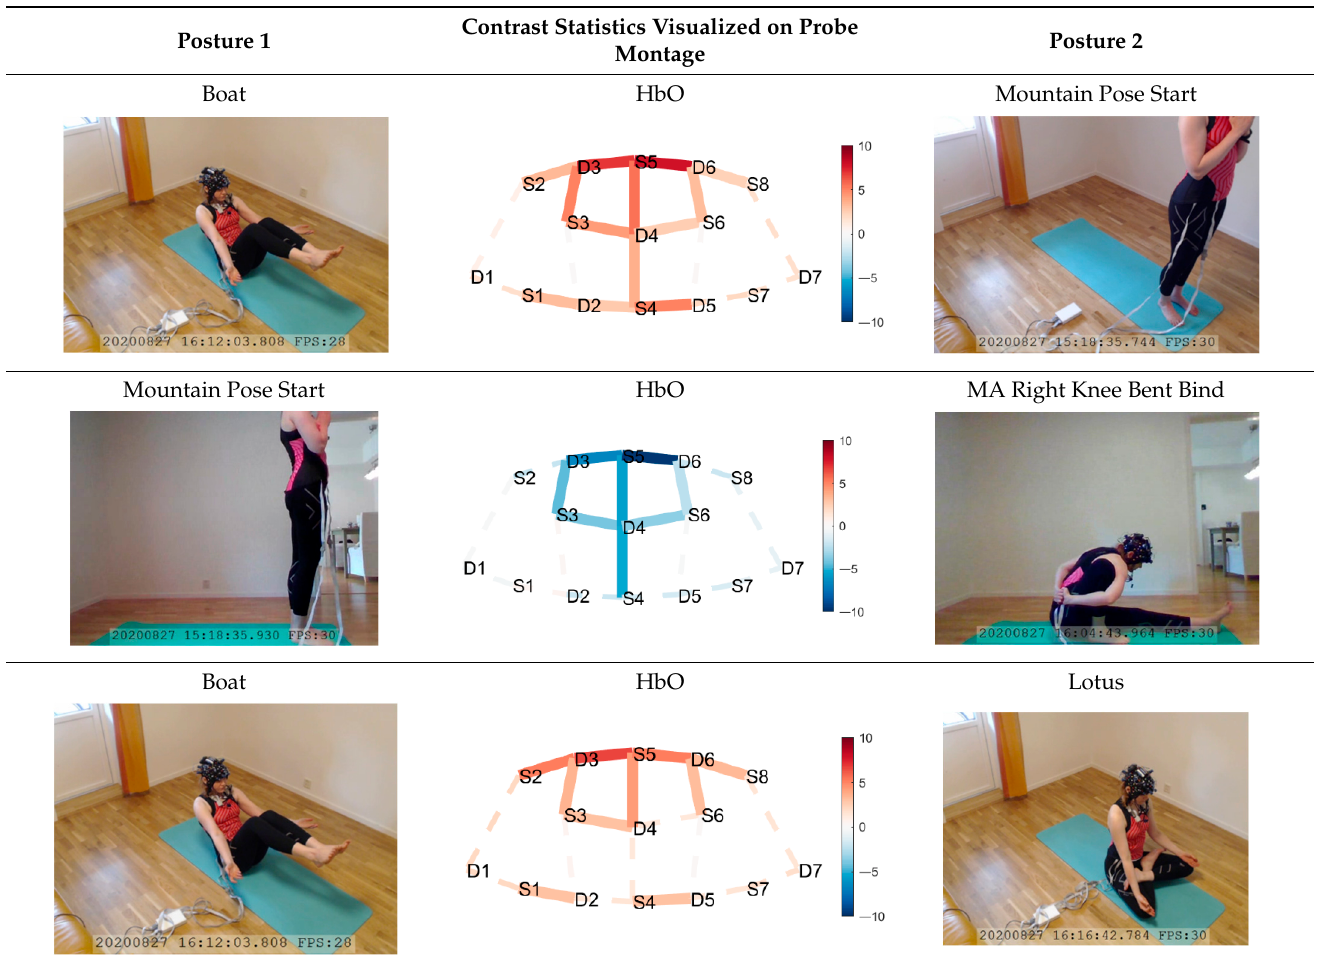
Table 1. Contrasts postures with greater statistical differences. Contrasts are shown as t -tests of Posture 1 minus Posture 2 1 .